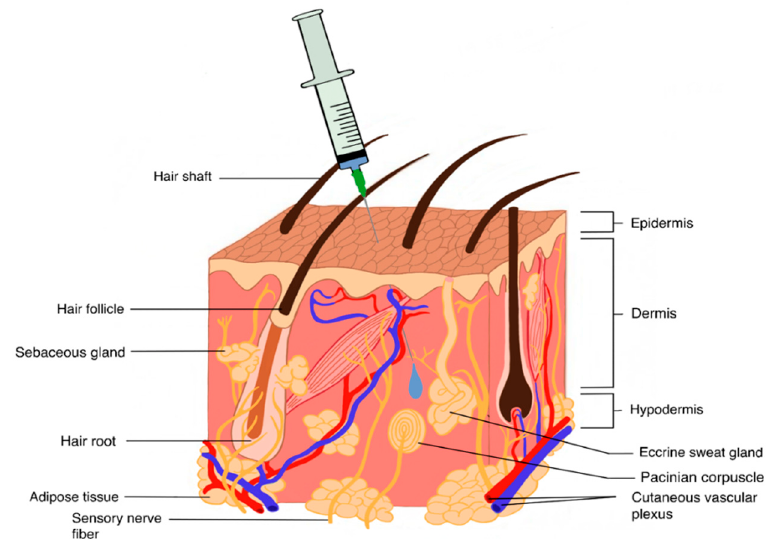
Figure 2. General representation of the SC tissue, which contains a complex structure of proteoglycans and collagen. The injection volume is limited to 2.0 mL; higher volumes can lead to injection site pain due to a rapid build-up of hydrostatic